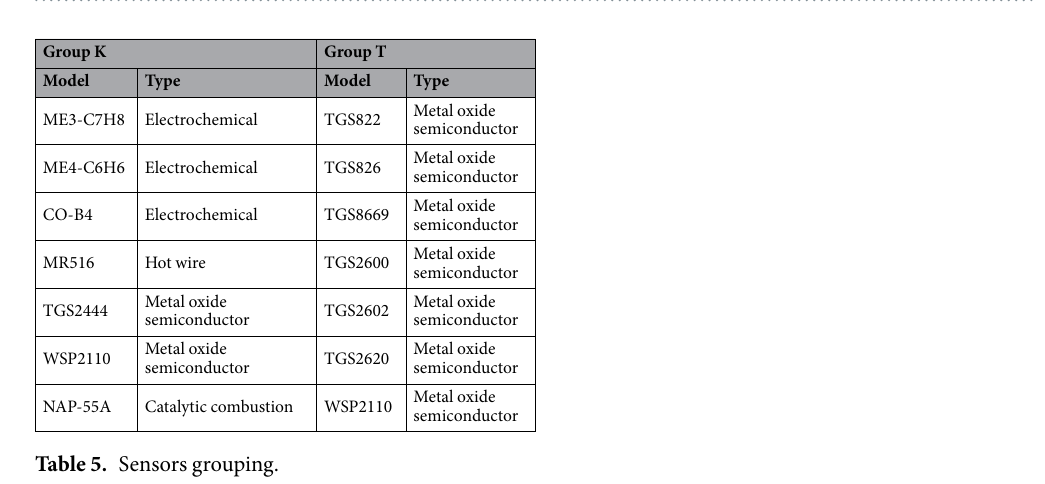
Table 4. Distinguishing results of lung cancer samples and healthy samples by different classification methods.